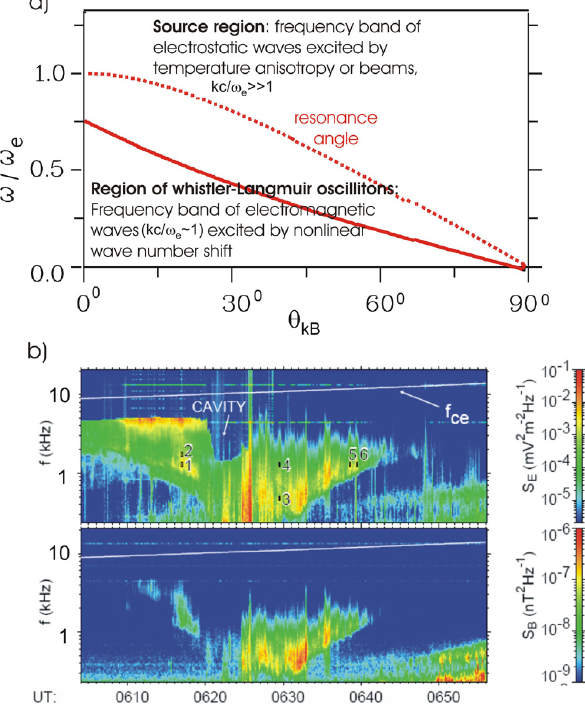
Fig. 16. Whistler-Langmuir waves in plasmas with G > 1: (a) schematic view of the two types of wave generation. Accord- ing to experimental conditions in the bottom panel, G = 1 . 5 was taken. In the source region predominantly electrostatic waves with kc/ω e (cid:29) 1 are generated by temperature anisotropy and/or electron beams. The frequency of these unstable waves is approximately given by the resonance cone condition (dotted red line). Nonlin- ear wave number shift into the region kc/ω e ∼ 1 drives whistler- Langmuir oscillitons which are probably the main contribution to electromagnetic wave emission. The solid red curve represents their frequency-angle dependence. (b) Spectrogram of the electric (up- per panel) and magnetic components measured by the plasma wave instrument (PWI) onboard the Polar spacecraft (adapted from San- tolik and Gurnett,